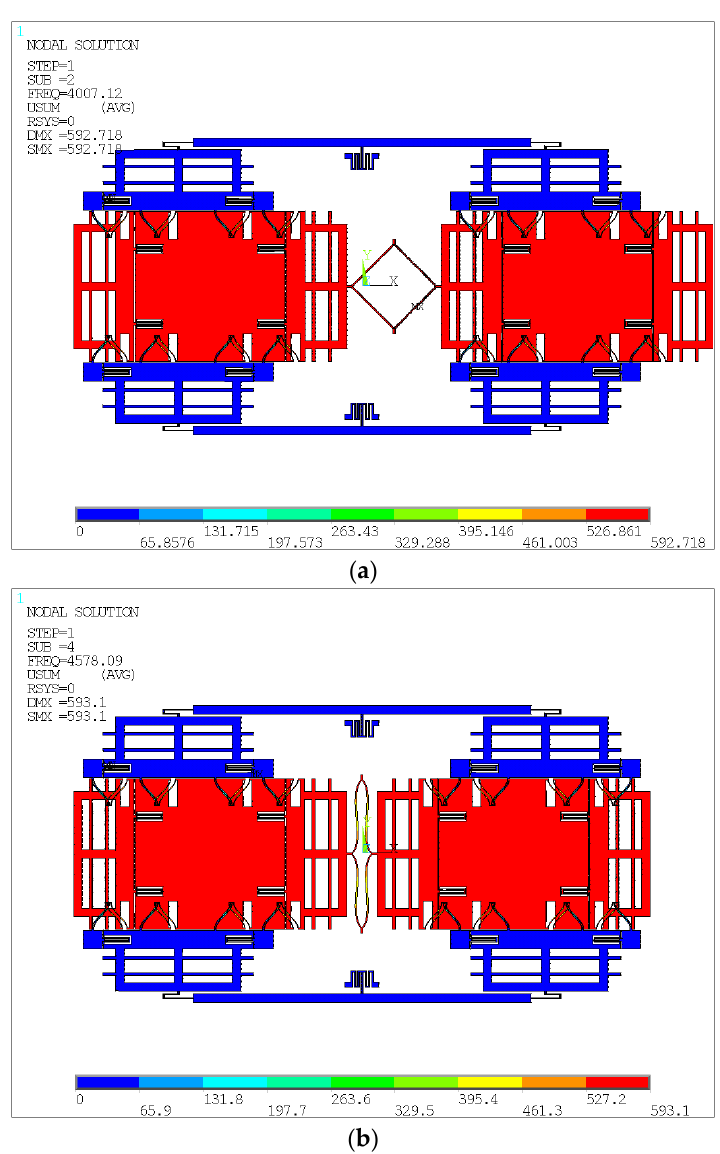
Figure 3. Modal analysis of the in-phase mode ( a ) and anti-phase mode ( b ) of Type B.